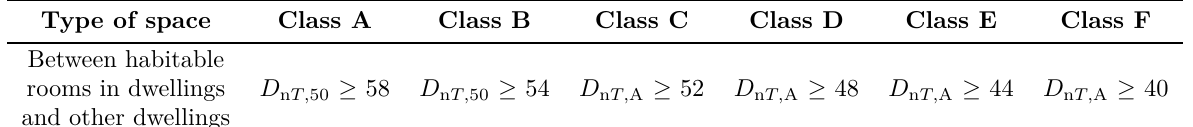
Table 2. Classes for airborne sound insulation [2].